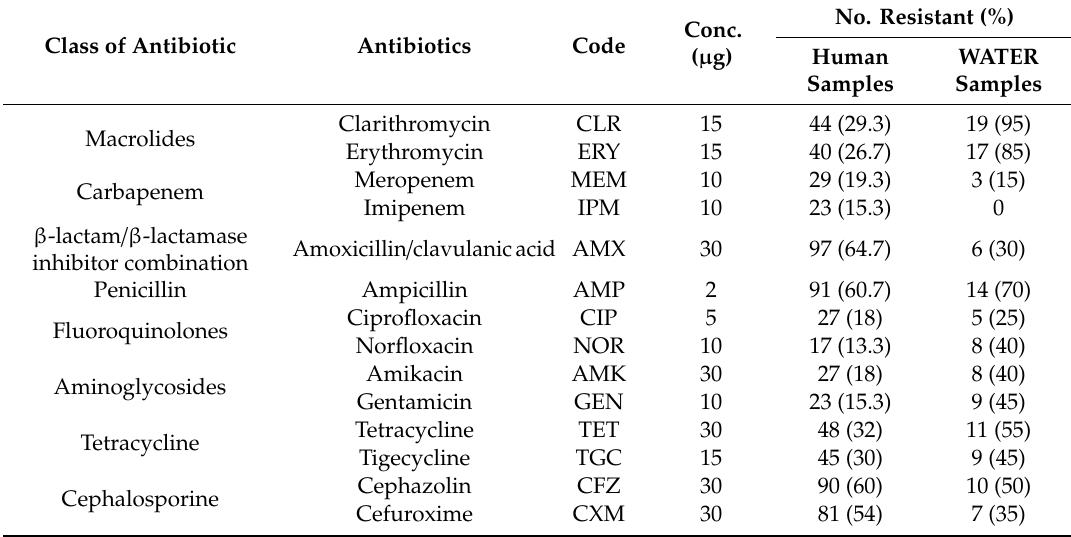
Table 3. Antimicrobial resistance profile of human Campylobacter isolates.